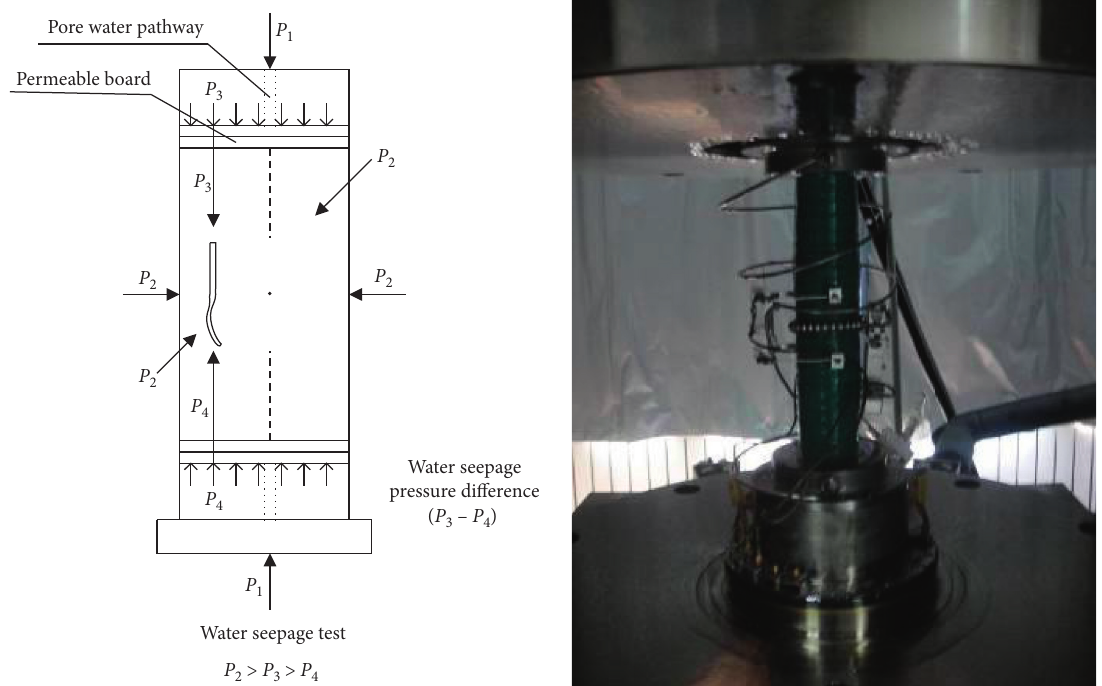
Figure 3: The principle of the penetration